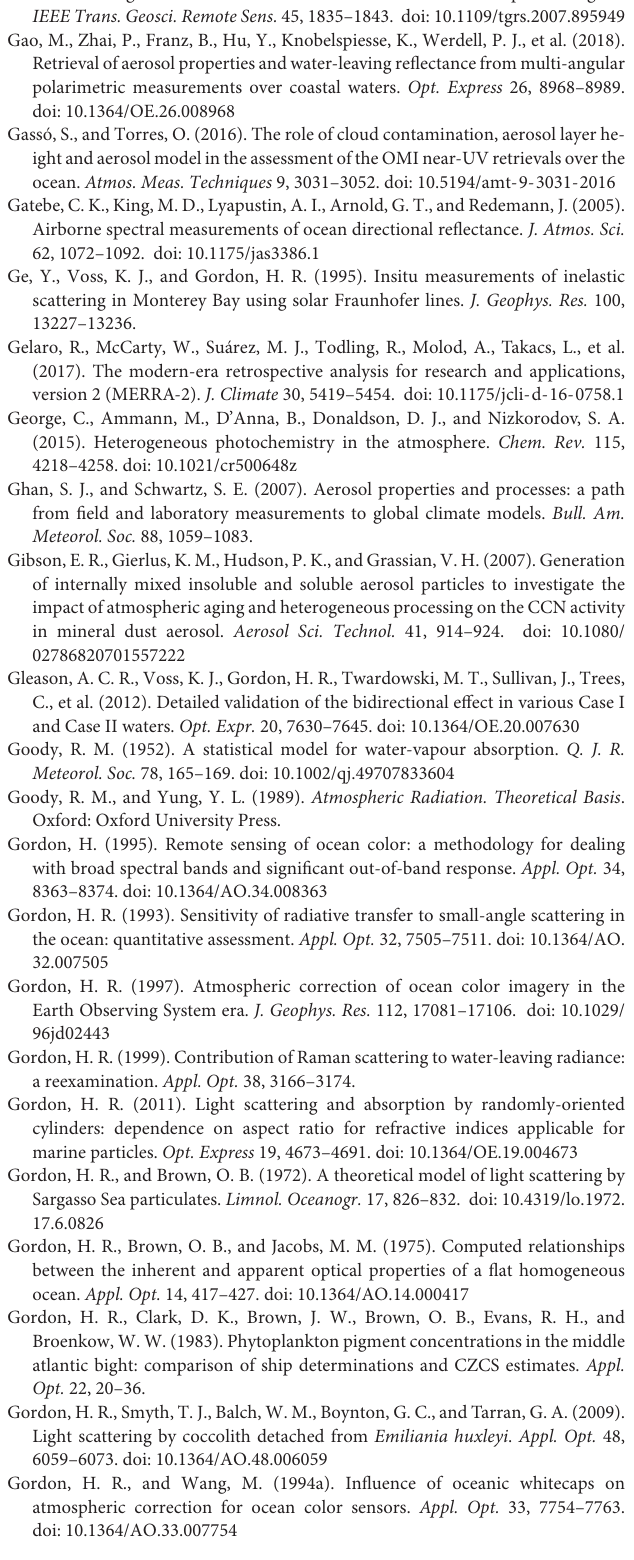
algorithm. Appl. Opt. 33, 443–452. doi: 10.1364/AO.33.000443 Green, S. A., and Blough, N. V. (1994). Optical absorption and